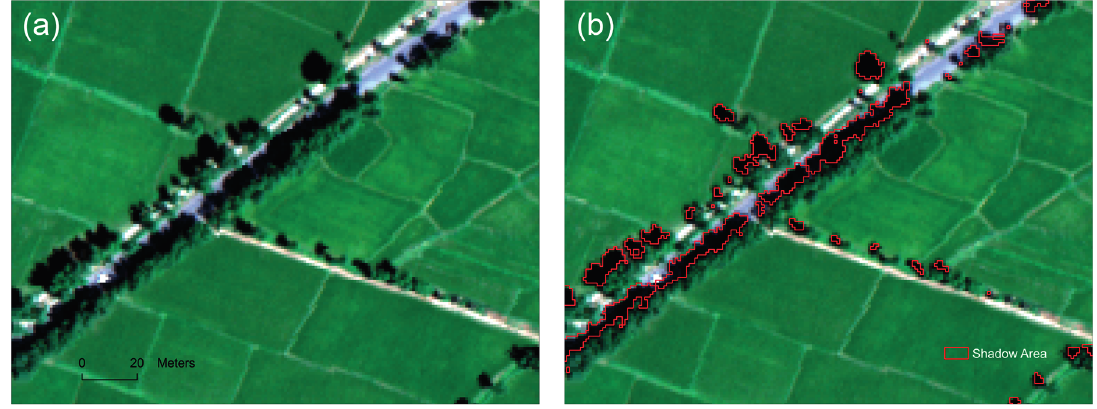
Figure 12. The PRI extracted shadow area: ( a ) image with shaded areas; ( b ) extracted shadow area (in red